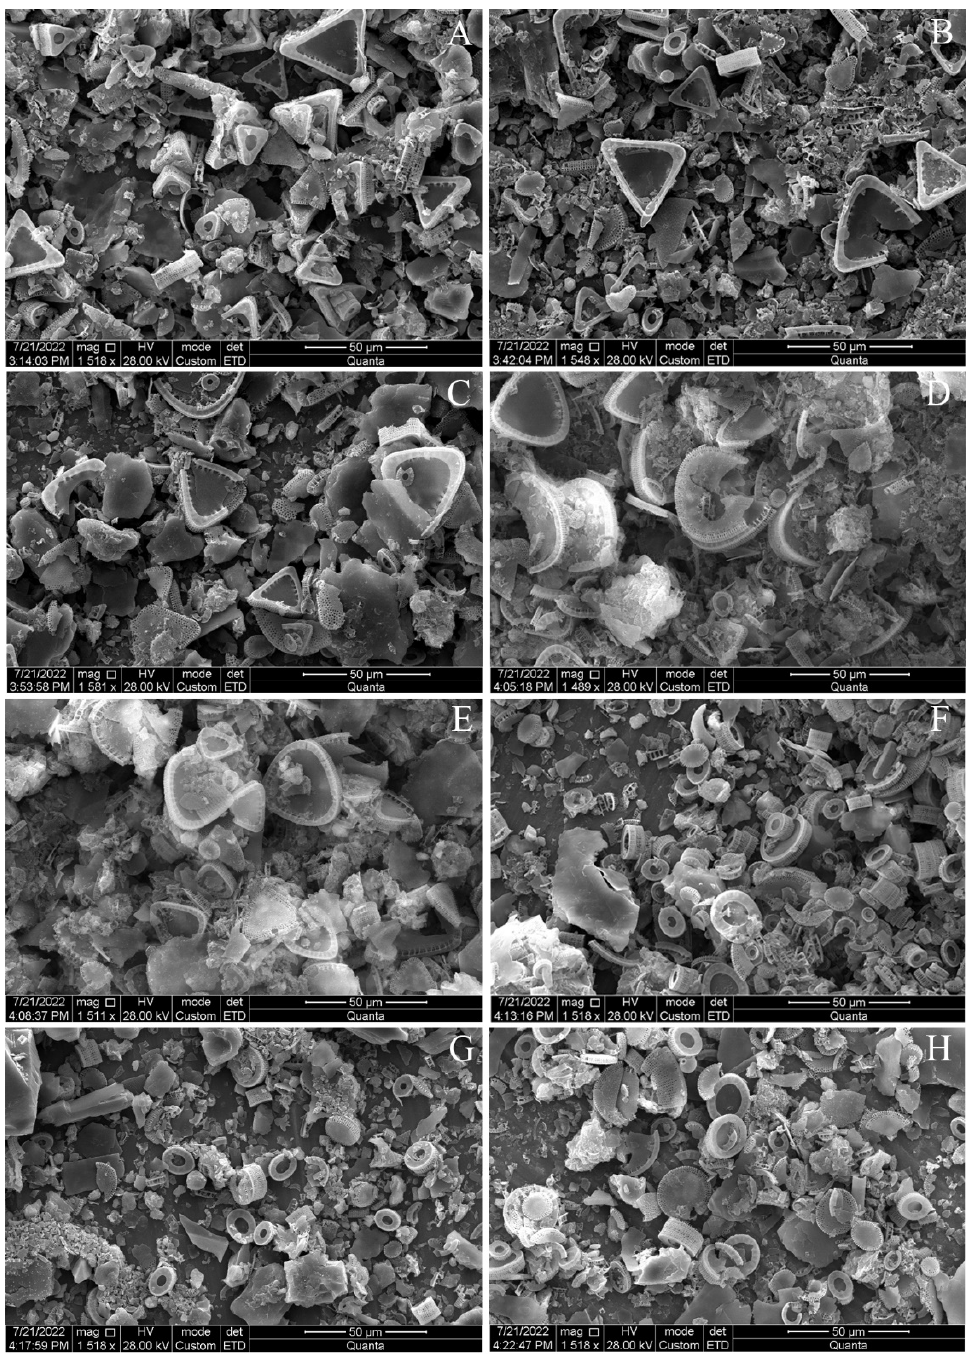
Figure 2. Samples of core 517 used for valve morphology analysis in SEM. ( A )—44.5 m; ( B )—46 m; ( C )—48 m; ( D )—53 m; ( E )—54 m; ( F )—55 m; ( G )—59 m; ( H )—61 m.